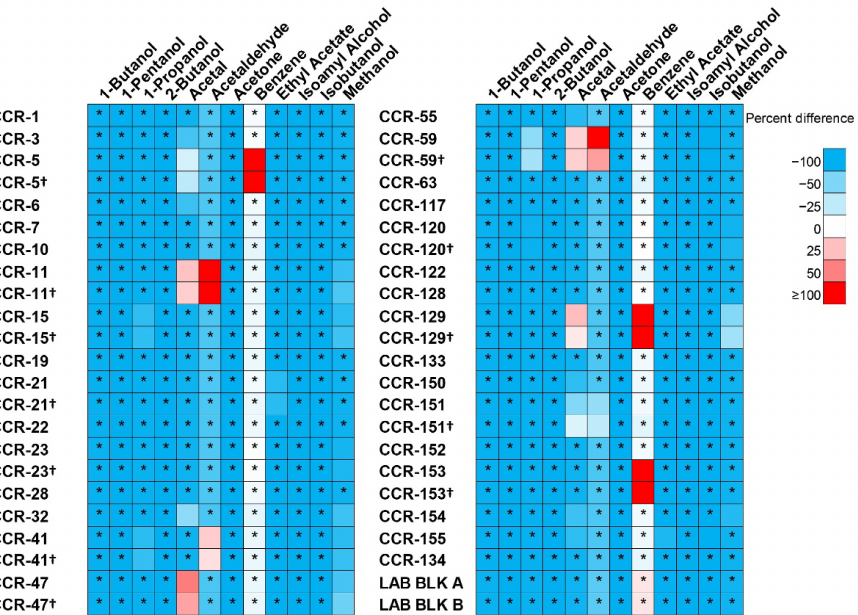
Figure 3. Impurity concentrations (expressed as percent difference relative to FDA specifications). Duplicate samples noted with † (expressed as percent difference relative to FDA specifications). Cells denoted with asterisks (*) refer to instances when impurity concentrations were equivalent to one half